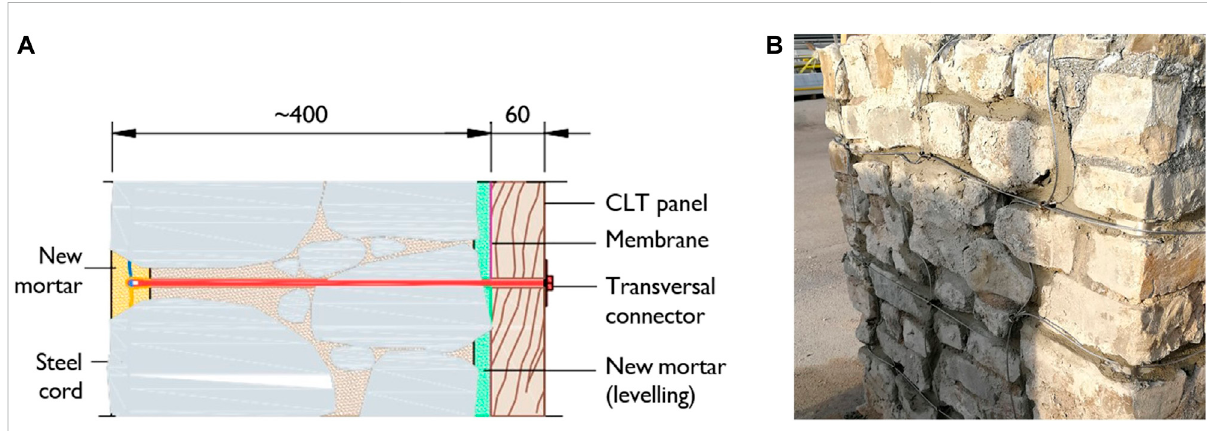
FIGURE 8 CLT panels combined with steel wire ropes for combined seismic and energy retro fi t of buildings: (A) vertical cross-section; (B) detail of the steel wire ropes at one side of the wall (adapted from (Borri et al., 2021)) .